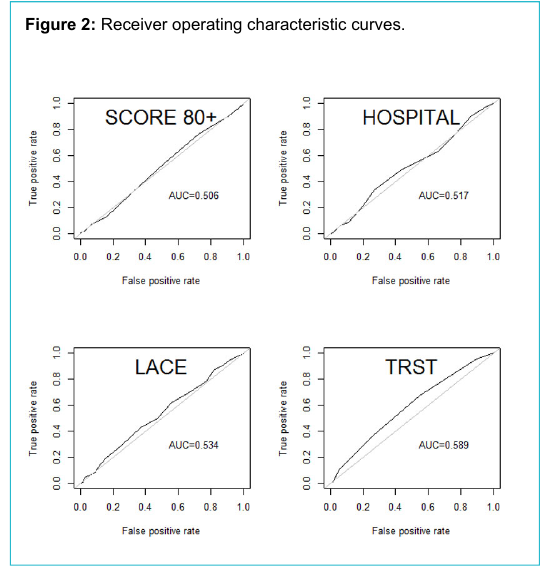
Figure 2: Receiver operating characteristic curves.